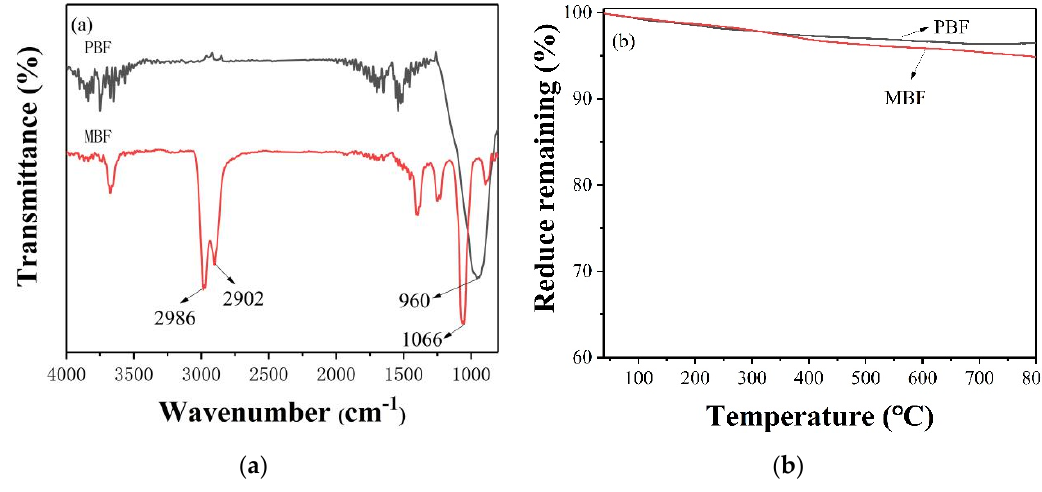
Figure 1. ( a ) Fourier transform infrared spectra (FTIR) of the pretreated basalt fiber (PBF) and modified basalt fiber (MBF); ( b ) Thermogravimetric analysis (TGA) curves of PBF and MBF under N 2